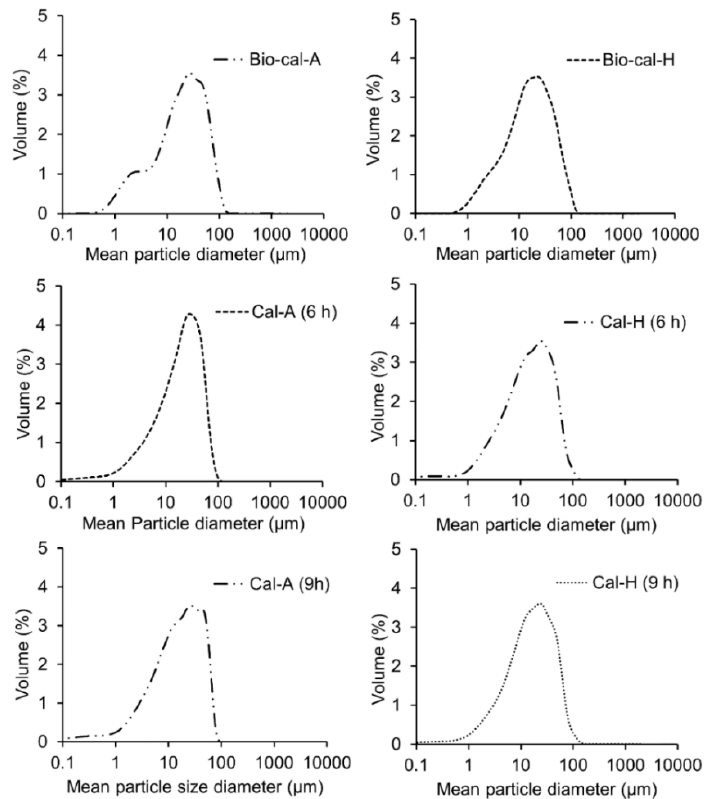
Figure 2. Particle size distribution of bio-calcium and calcined bone powders from salmon bones. For calcined samples, Cal-A and Cal-H had a more ordered and compact form with uniform particle size distribution as shown by mono-modal distribution. In addition, the removal of organic compounds possibly resulted in the lower particle diameters due to more compactness of